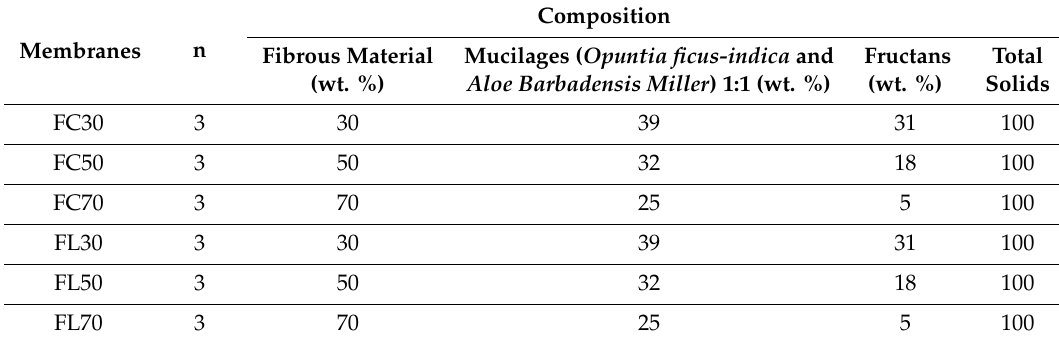
Table 1. Composition of Lignocellulosic Biopolymer Membranes (LBMs).